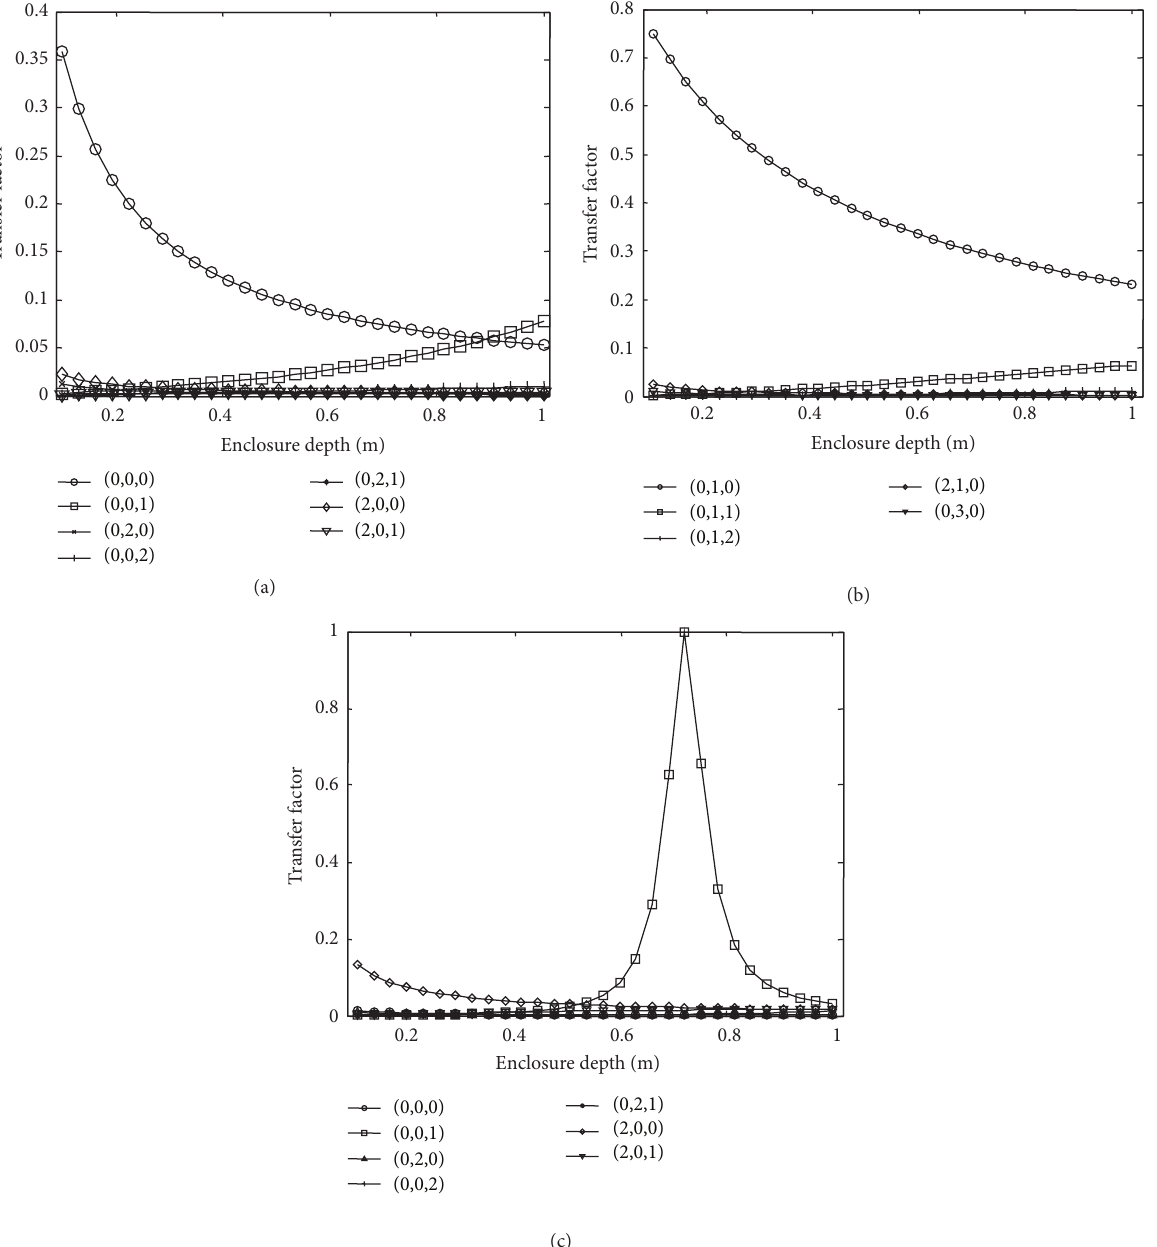
the (0,0,0) enclosure mode and the (1,1) panel mode